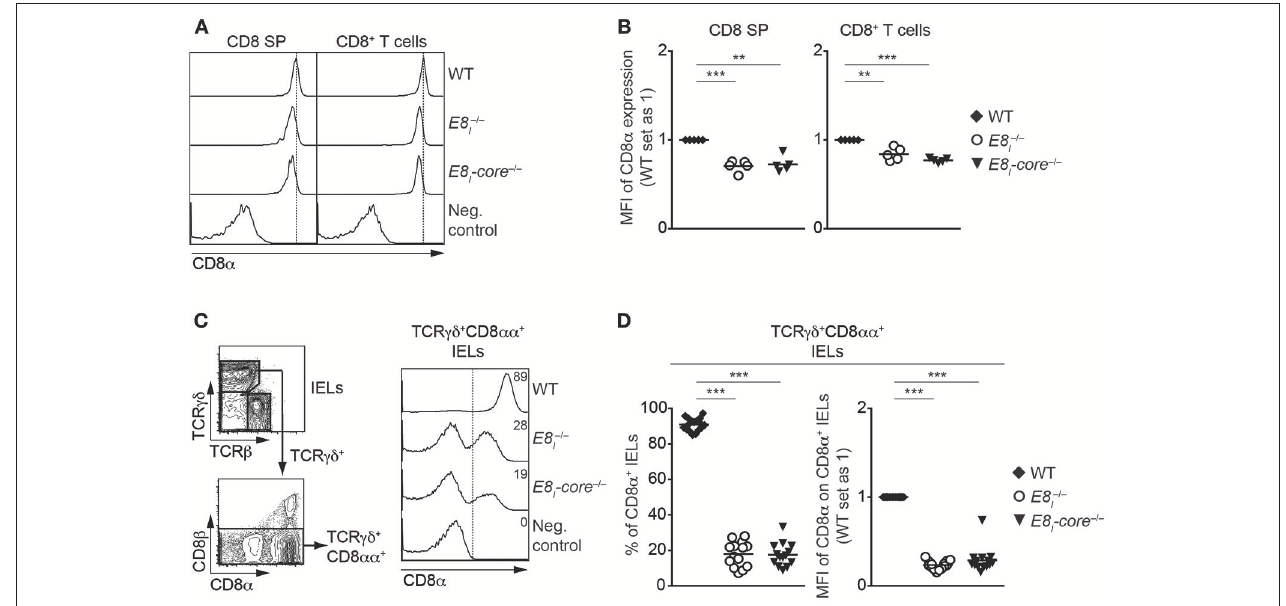
FIGURE 2 | E8 I -core represents the core enhancer region of E8 I . (A) Histograms showing CD8 α expression on CD8SP thymocytes and splenic CD8 + T cells isolated from wild-type (WT), E8 I − / − and E8 I - core − / − mice. The gating strategy is shown in Figures S3A,C . Dotted vertical lines indicate the peaks of CD8 α expression on WT cells. CD8 α expression on WT CD4SP thymocytes (left panel) or CD4 + T cells (right panel) is shown as negative staining control. (B) Diagrams showing the relative mean fluorescence intensity (MFI) of CD8 α expression on CD8SP thymocytes (left) and splenic CD8 + (right) T cells isolated from wild-type (WT), E8 I − / − and E8 I - core − / − mice. (C) Representative gating strategy for the analysis of CD8 α expression on TCR γδ + CD8 αα + IELs (left panel) and histograms showing CD8 α expression on TCR γδ + CD8 αα + IELs isolated from wild-type (WT), E8 I − / − and E8 I - core − / − mice (right panel). CD8 α expression on WT CD19 + B cells is shown as a negative staining control. Dotted lines and numbers indicate gating region for the CD8 α + population and the percentages of the CD8 α + population, respectively. (D) Diagrams showing the percentage of the CD8 α + population (left panel) and MFI CD8 α expression levels (right panel) within TCR γδ + CD8 αα + IELs isolated from wild-type (WT), E8 I − / − and E8 I - core − / − mice. Each dot represents one mouse. Horizontal bars indicate mean values. A one-way ANOVA analysis followed by Tukey’s multiple-comparison test was performed for statistical analysis. (B,D) The MFI values of WT cells were set as 1. Each dot represents one mouse. Horizontal bars indicate mean values. A one-sample t -test was performed for statistical analysis, where the values obtained from each group of the mutant mice were compared to the WT ones. The p -values were defined as following: **, p < 0.01; ***, p < 0.001. Data are representative of 5–6 mice (A,C) or show the summary of 5–6 mice (B) mice, 14–17 mice (D) analyzed in 5 (A,B) and 16 (C,D) independent